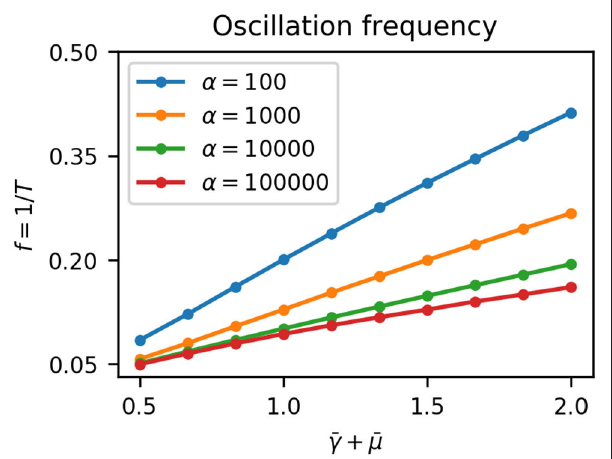
FIGURE 4 | Oscillation frequency f (or period T ) depends on the effective degradation rate of repressors ¯ γ + ¯ µ . For a given maximum gene expression rate α the frequency is proportional to the effective degradation rate, and increasing α decreases the frequency.